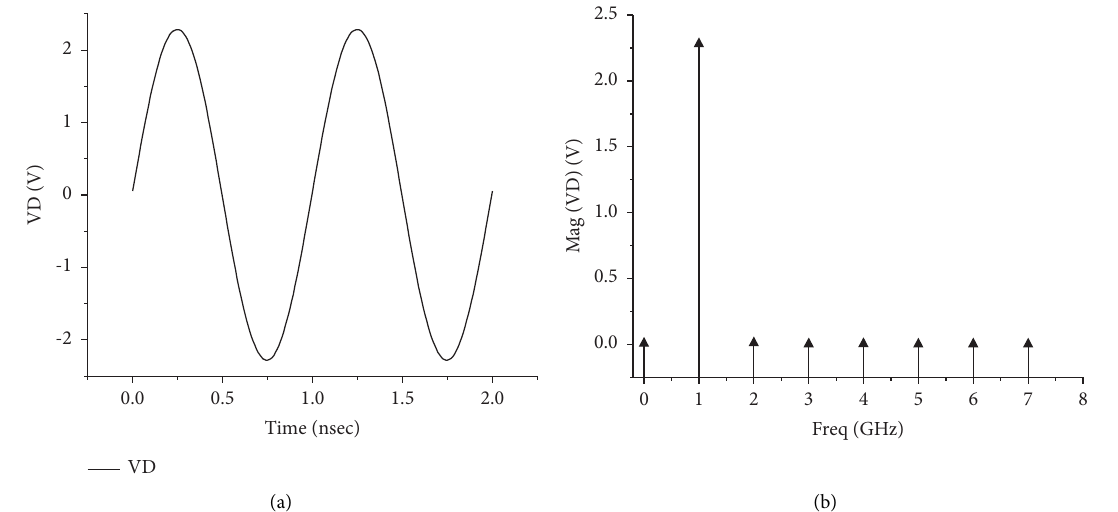
Figure 8: Waveform of VD test point when the waveform of VR is single period: (a) waveform of time domain and (b) magnitude of the frequency domain.